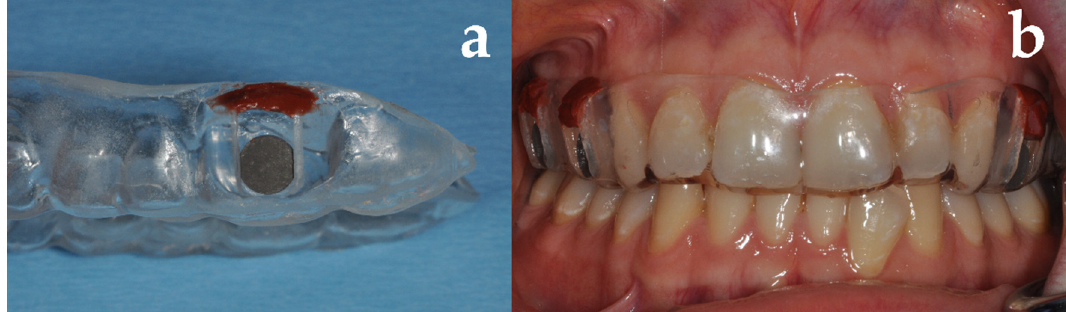
Figure 1. Maxillary splint with recesses for mounting Ti-Zr discs. ( a ) Recess used for mounting the Ti-Zr discs allowing for easy removal, ( b ) intraoral situation with splint in place.